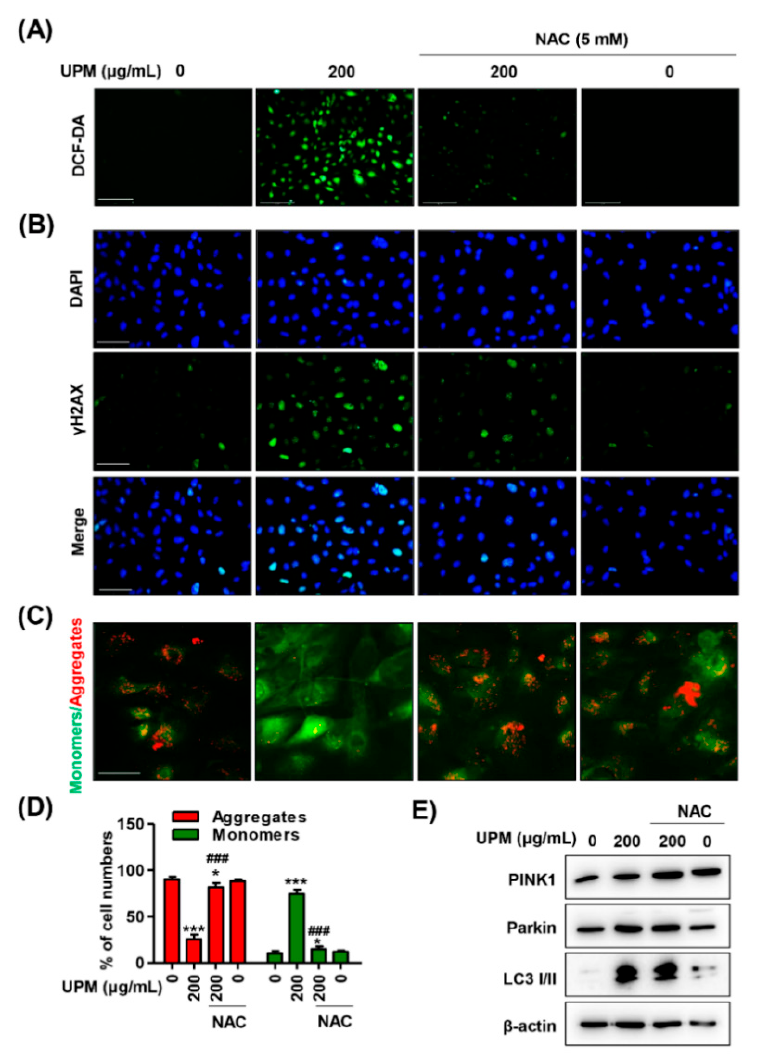
Figure 6. Inhibition of ROS suppresses UPM-induced DNA and mitochondrial damage in AREP-19 cells. ( A ) Representative fluorescence images of DCF-DA-stained cells. Scale bar: 200 μ m. ( B ) The fluorescence expression of γ H2AX (green). DAPI was used to counterstain the nuclei (blue). Scale bar: 75 μ m. ( C ) Representative images of JC-1 fluorescence staining. Monomers showing green fluorescence define low MMP, and aggregates showing red fluorescence characterize high MMP. Scale bar: 25 μ m. ( D ) Quantification of JC-1 red and green intensities. Data are expressed as the mean ± SD ( n = 4). * p < 0.05 and *** p < 0.001 when compared to untreated cells. ### p < 0.001 compared to 200 μ g/mL UPM-treated cells. ( E ) The expression of mitophagy-regulated proteins.